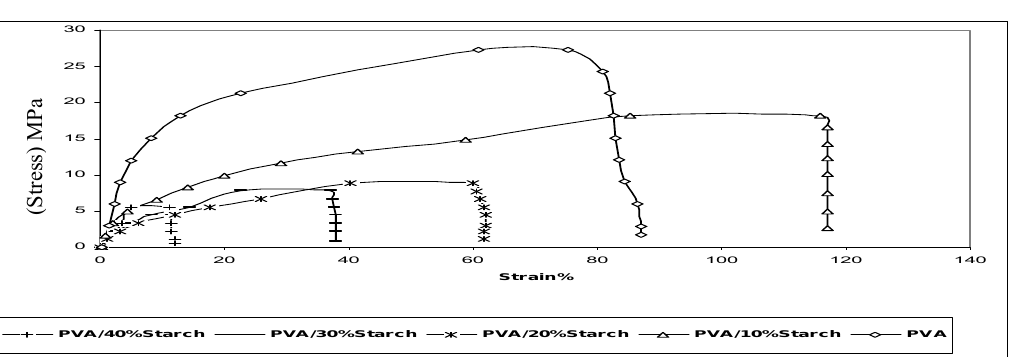
Fig.6: The stress strain curves of PVA, and Starch/PVA/sugar at different ratio.